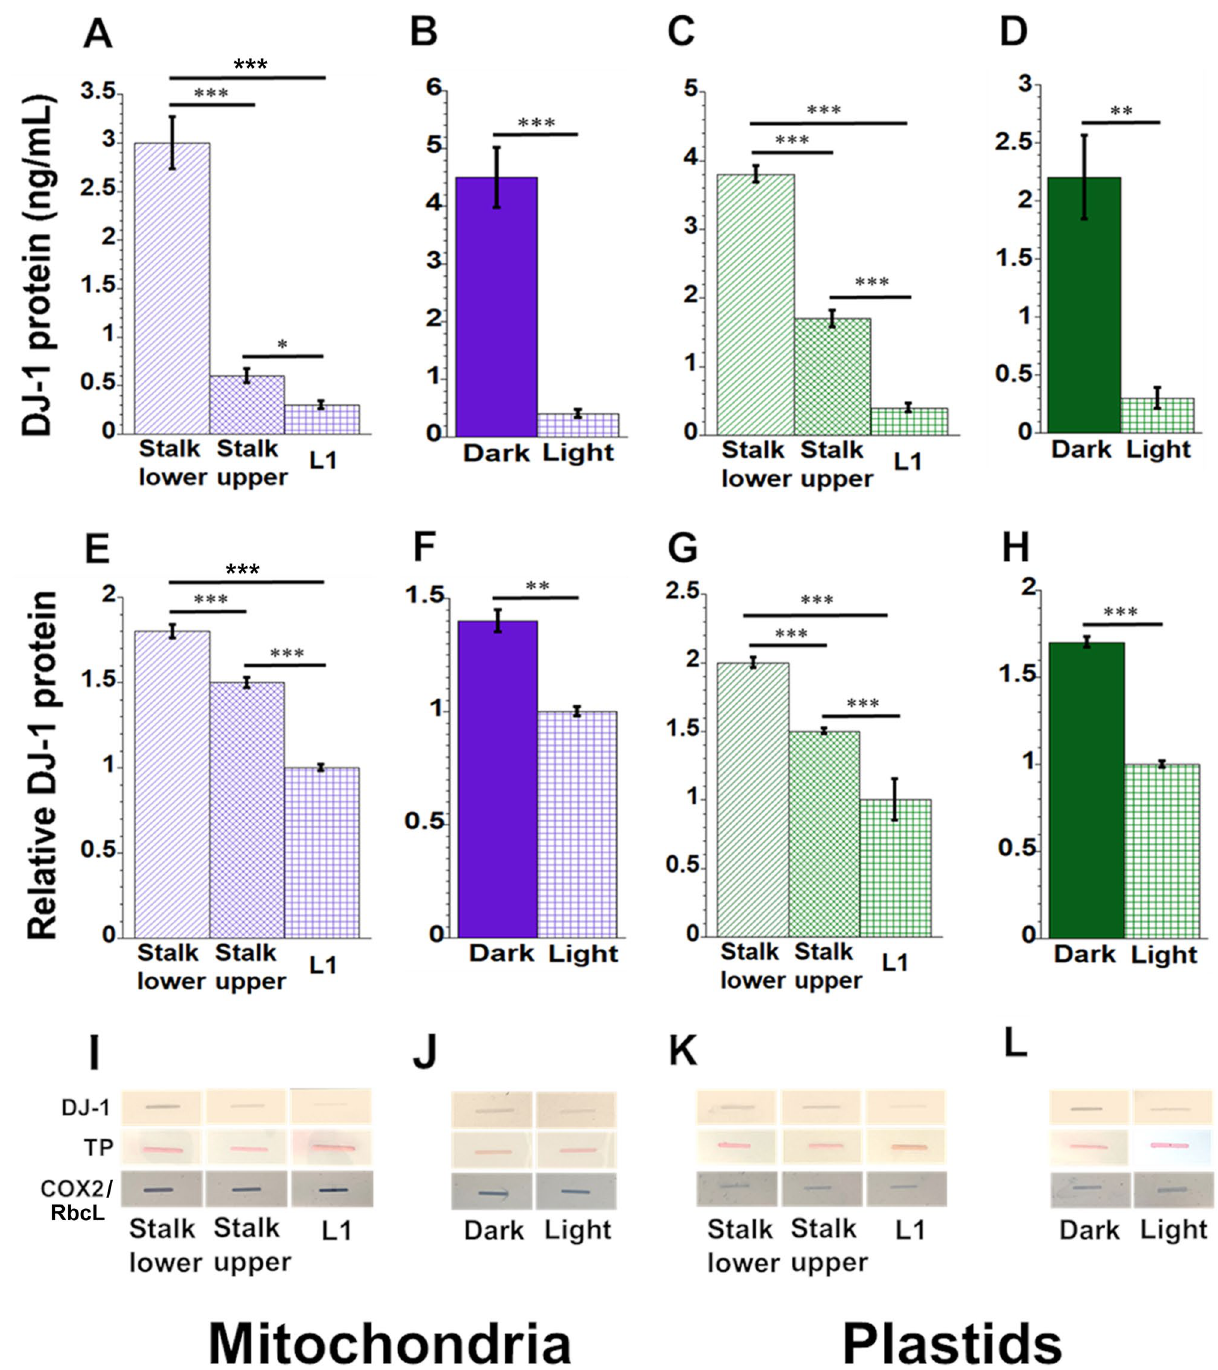
Figure 3. DJ-1 protein in maize mitochondria and plastids. The amount of DJ-1 protein from isolated mitochondria and plastids was measured using anti-DJ-1 antibodies with competitive ELISA ( A – D ) and slot blot ( E – H ) assays. For ELISA, DJ-1 protein in mitochondria was measured as ng/mL. Representative images of slot blot assays are shown ( I – L ) and the relative DJ-1 protein was determined, where the image intensity was set to 1 for leaf 1 (L1) in ( E , G ) and for light-grown leaves in ( F , H ). Uppermost panels of I-L show DJ-1 proteins, middle panels show the total protein (TP) levels in samples, and lowermost panels show mitochondrial (COX2)- and plastid (RbcL)-specific proteins (COX2 in panels I and J; RbcL in panels K and L). Cross-reactivity of maize organellar DJ-1 with anti-DJ-1 antibodies (human Park7) was confirmed and is shown in Supplementary Information, Fig.